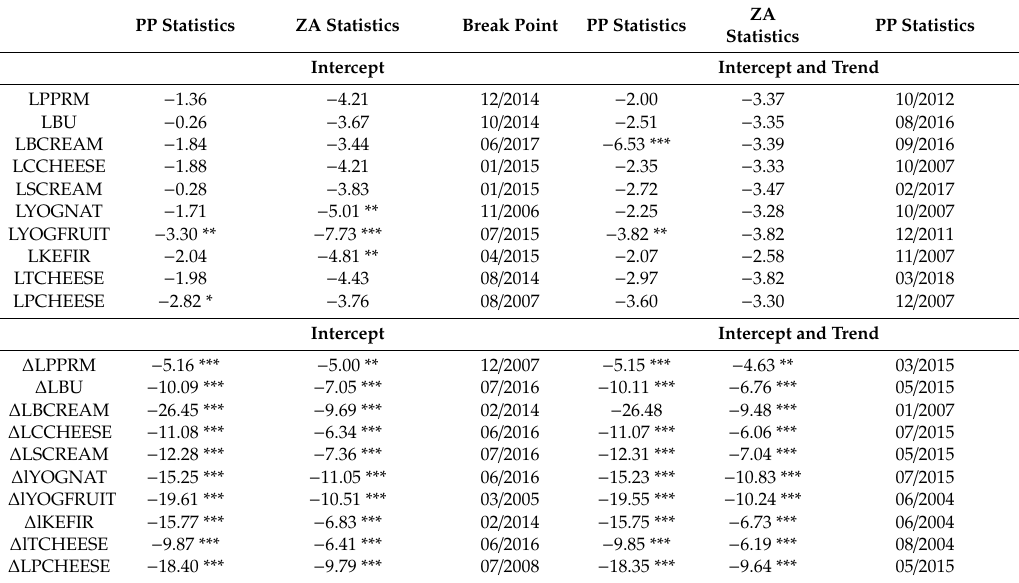
Table 2. Root tests without, and with, a structural